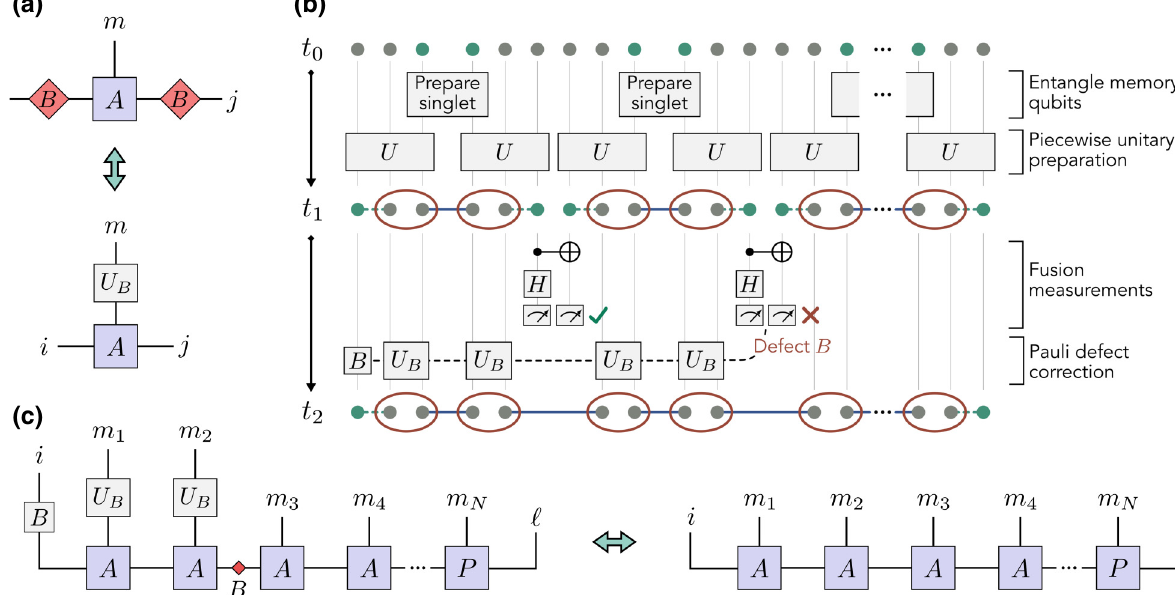
FIG. 4. The measurement-assisted preparation of the AKLT state. (a) The manifestation of Z 2 × Z 2 symmetry at the level of the local tensor A . Conjugation by B applied to the virtual legs is equivalent to application of U B on the physical leg. (b) The circuit diagram of our measurement-assisted preparation. We begin by applying a single time step of the sequential preparation, forming many two-site AKLT states in parallel. We then fuse together independent chains through Bell measurement of their memory qubits, introducing the Pauli defect B . This defect is then removed by applying the symmetry action of (a). Notably, this final step does not have to be carried out on quantum hardware, as the unitary U B merely permutes the encoding of the spin-1 basis states. (c) A tensor-network illustration of the removal of the defect B using the Z 2 × Z 2 symmetry of the AKLT